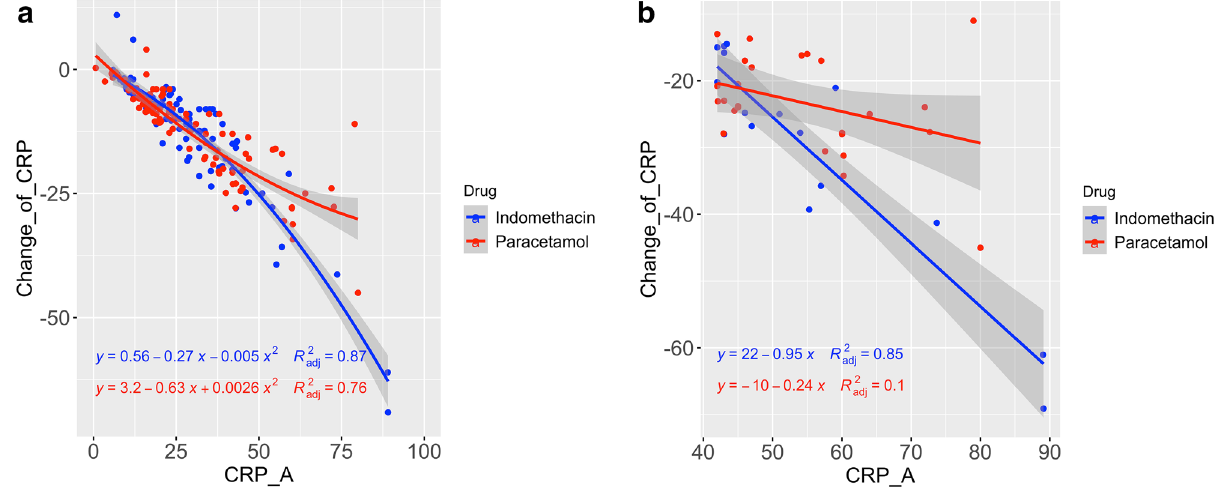
Figure 5. ( a ) Change in CRP vs. CRP on admission. ( b ) Change in CRP vs. CRP on admission: a closer look of higher CRP on